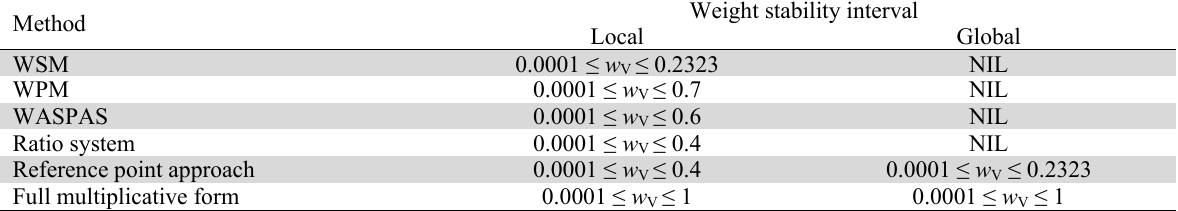
Fig. 5. Results of high dimensional weight sensitivity analysis for Example 2 High dimensional weight stability intervals for Example